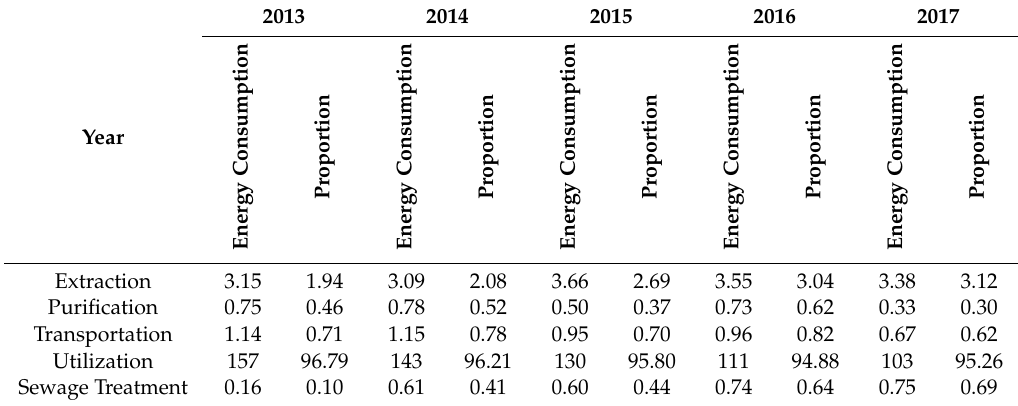
Table 2. Energy consumption and proportion of total energy consumed for each stage of the life cycle of water resources in Ordos, China. (Dimension of energy consumption: 10 8